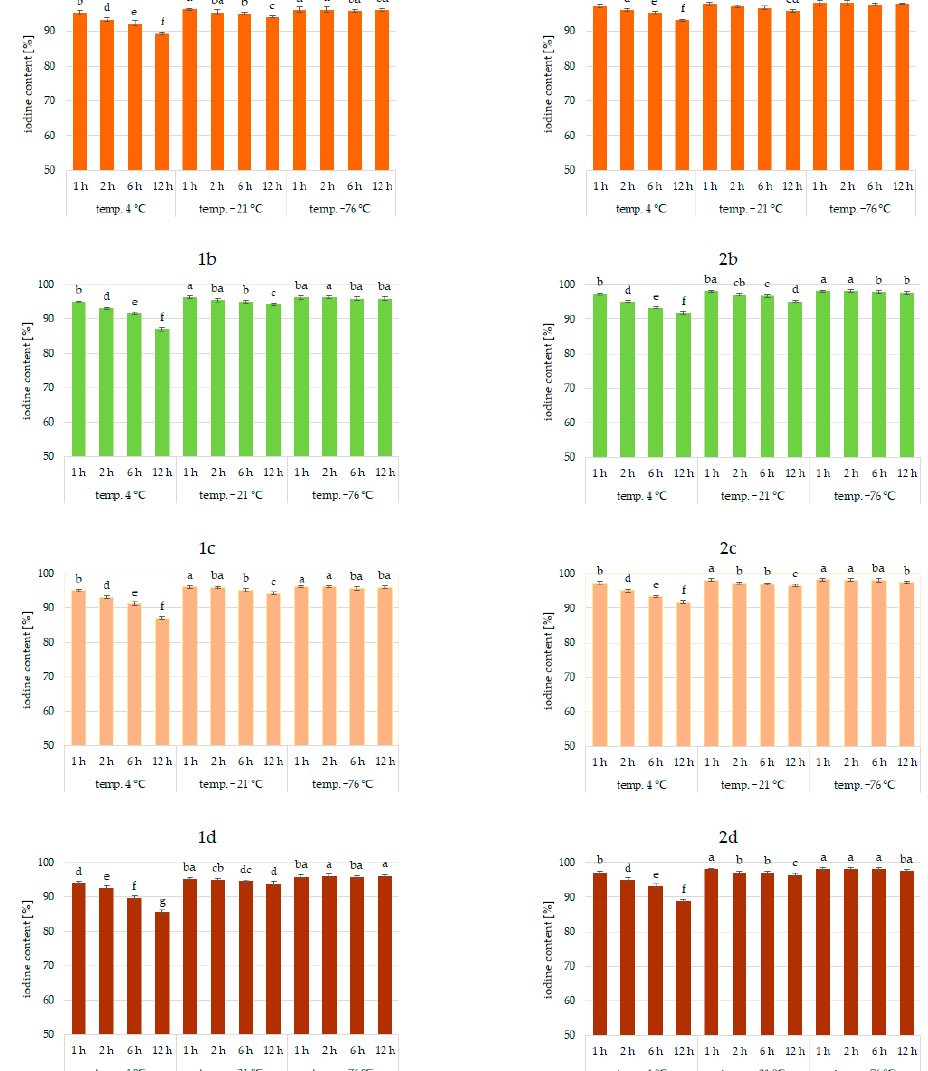
Figure 2. Iodine content (%) in pumpkin ( 1a , 2a ), broccoli ( 1b , 2b ), cauliflower ( 1c , 2c ), and carrot ( 1d , 2d ) fortified with KI and KIO 3 , respectively, at hydration ratio 1:2 and different temperatures (4 °C, − 21 °C, − 76 °C) and times; different letters (a–g) denote a significant difference at p < 0.05 (one-way ANOVA, and post hoc Tukey test). Mean values ( n = 4). Error bars are confidence intervals with a confidence coefficient of 0.95.